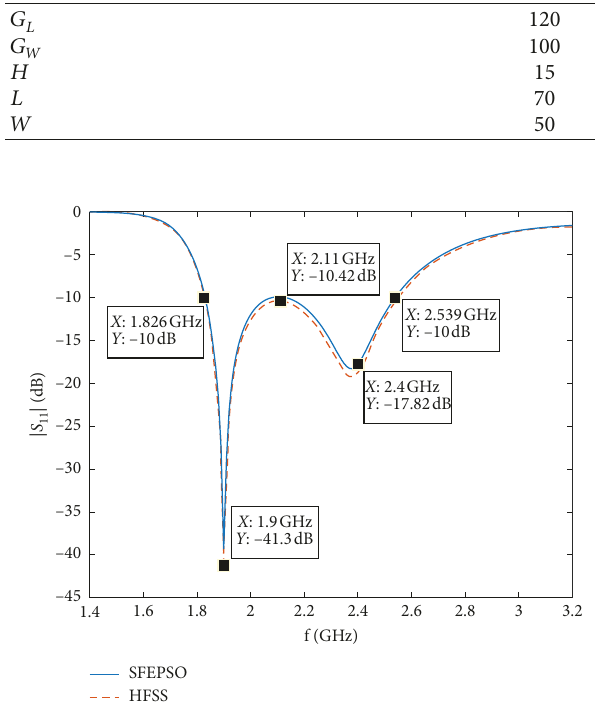
Figure 3: Results of the optimized E-shaped dual-frequency